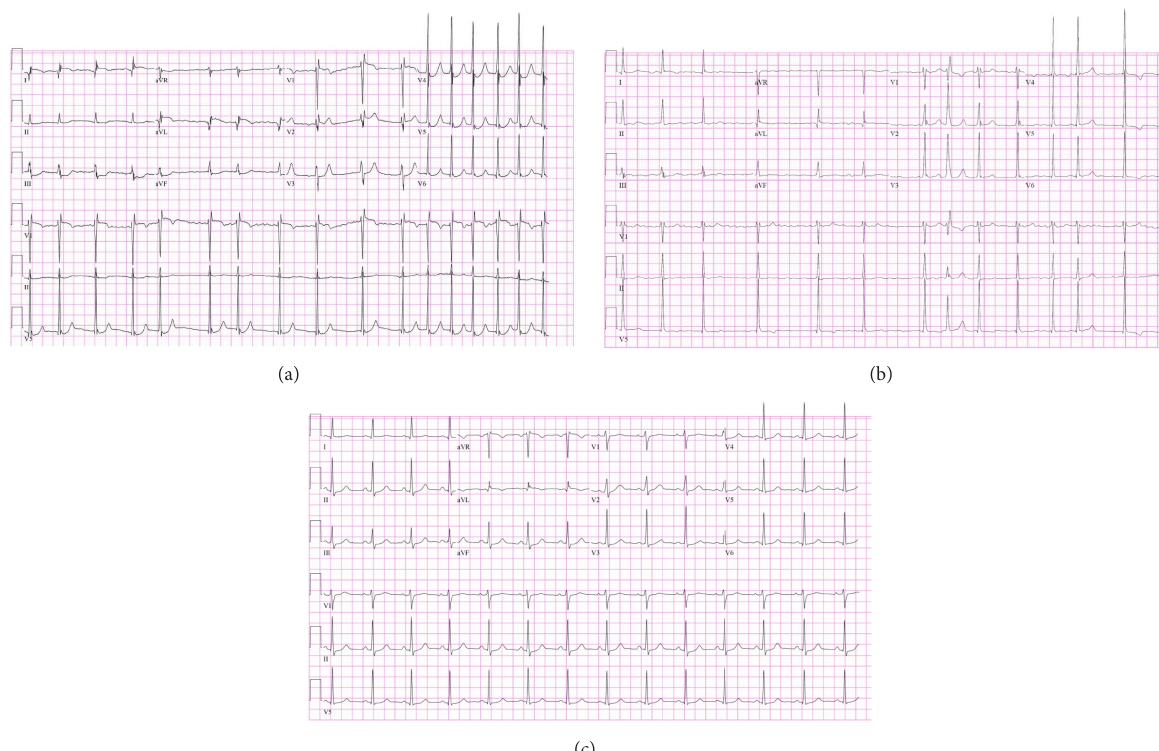
Figure 1: Patient’s EKGs showing (a) atrial fibrillation with ST elevations in leads I, aVL, V1, and V2 with reciprocal changes in leads III and aVF, (b) atrial fibrillation with resolution of ST segment elevations, and (c) normal sinus rhythm. Normal